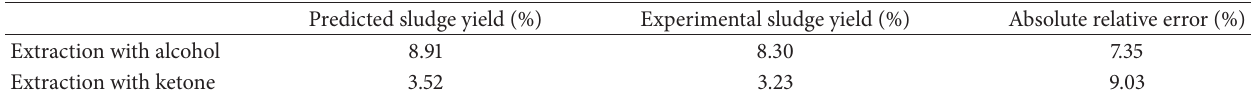
Figure 4: (a) Multivariate model relating the sludge yield 𝑌 𝐾 during liquid-liquid extraction with ketone to process variables 𝑡 , 𝑇 , and 𝑟 . (b) Corresponding residual analysis. Table 5: Experimental validation of optimized extraction